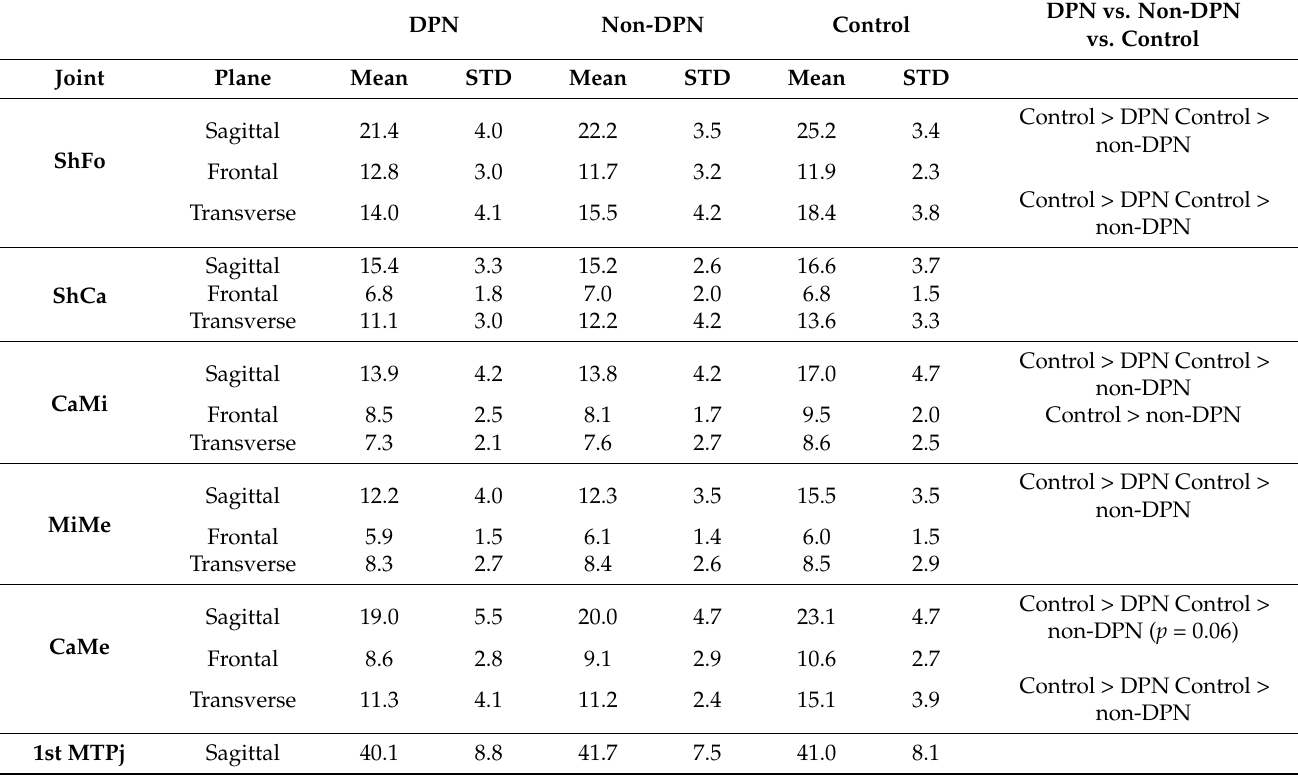
Table 4. Mean and standard deviation of foot joints ROM [deg] in stance in neuropathic (DPN), non-neuropathic (non-DPN) and control groups. DPN Non-DPN Control